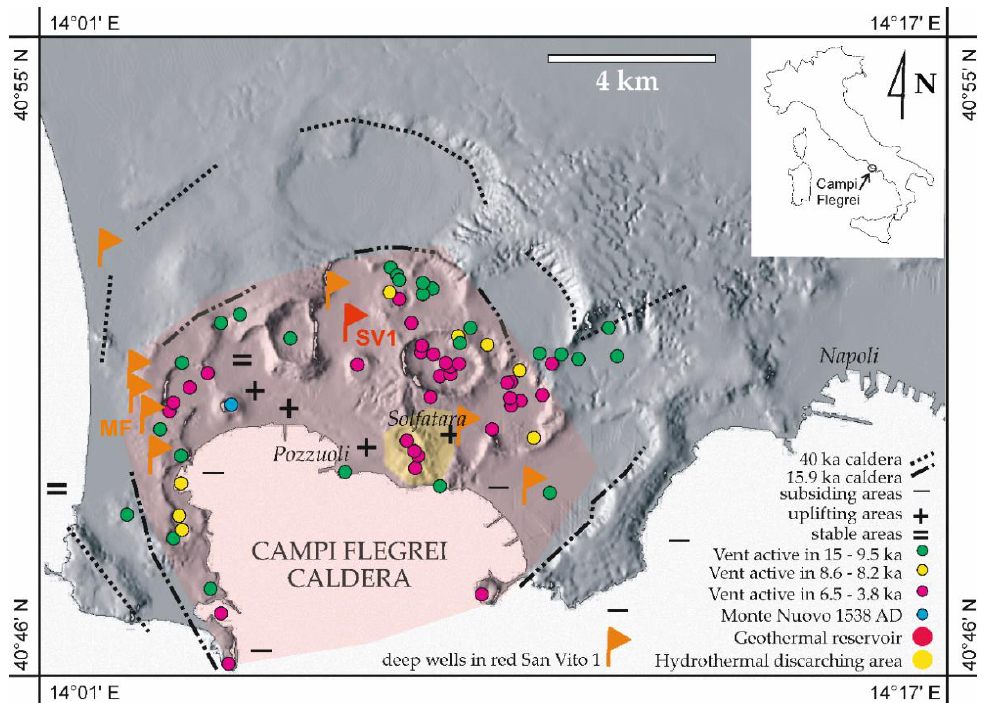
Figure 1. The Campi Flegrei volcano with the main information about physical aspects, ages, geo- logical relations, relief, vents active in the most recent volcanic history, deformation areas, hydro- thermal and discharge zones, SAFEN- AGIP’s deep wells (modified from [5]). Coordinates in de- grees – minutes – seconds. In red is the San Vito 1 well (SV1) object of this study. MF is the Mofete wells area. DTM (digital terrain model) of the area from the Laboratorio di Geomatica e Cartografia of the Istituto Nazionale di Geofisica e Vulcanologia, Osservatorio Vesuviano, Italy.